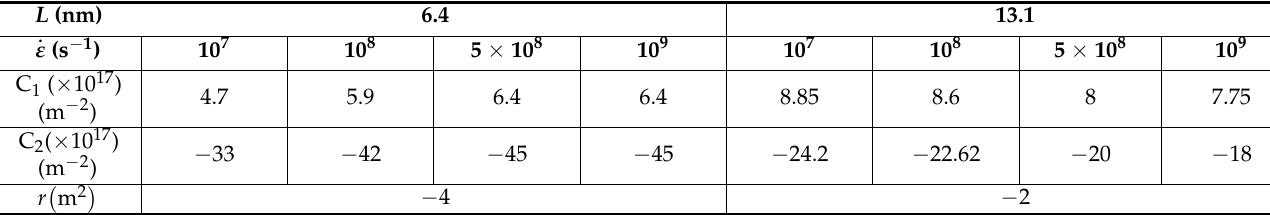
Table 3. Equation (8) parameter values.